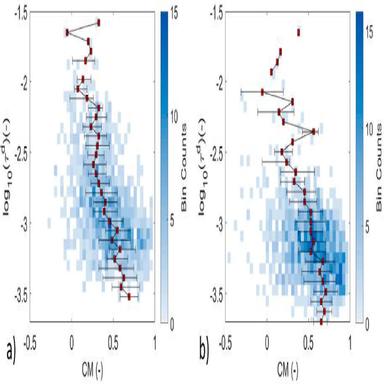
Collective motion CM against logarithm of differential tortuosity τd for a) Tape A, and b) Tape B. For each horizontal bin, the median of the distribution is represented with red squares. The error bars represent the quartile interval. (For interpretation of the references to colour in this figure legend, the reader is referred to the Web version of this article.)